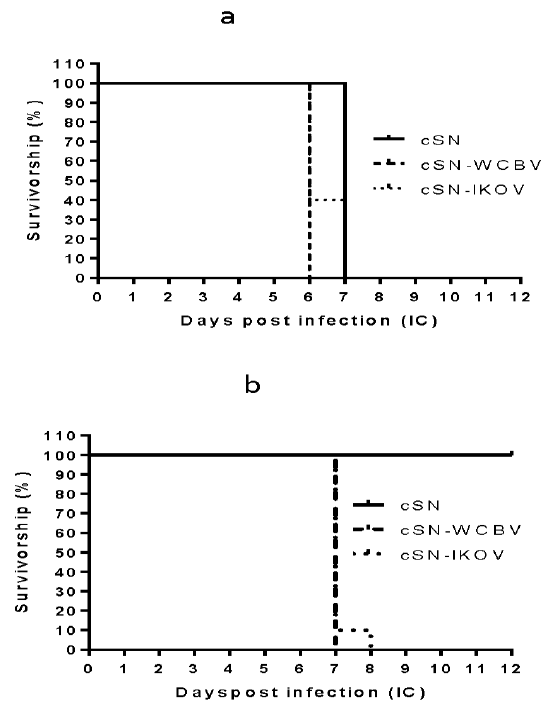
Figure 2. Survival curve of mice challenged IC. ( a ) The survival curve of mock vaccinated mice ( n = 5 per virus). ( b ) The survival curve of mice vaccinated with VeroRAB and challenged with cSN, cSN-WCBV-G, or cSN-IKOV-G ( n = 10/virus). Each mouse was challenged with 100 ffu/30 μL of virus via the intracranial route. Mice were observed for 28 days but results only shown up to day 12 for clarity as after this point no further mice developed clinical